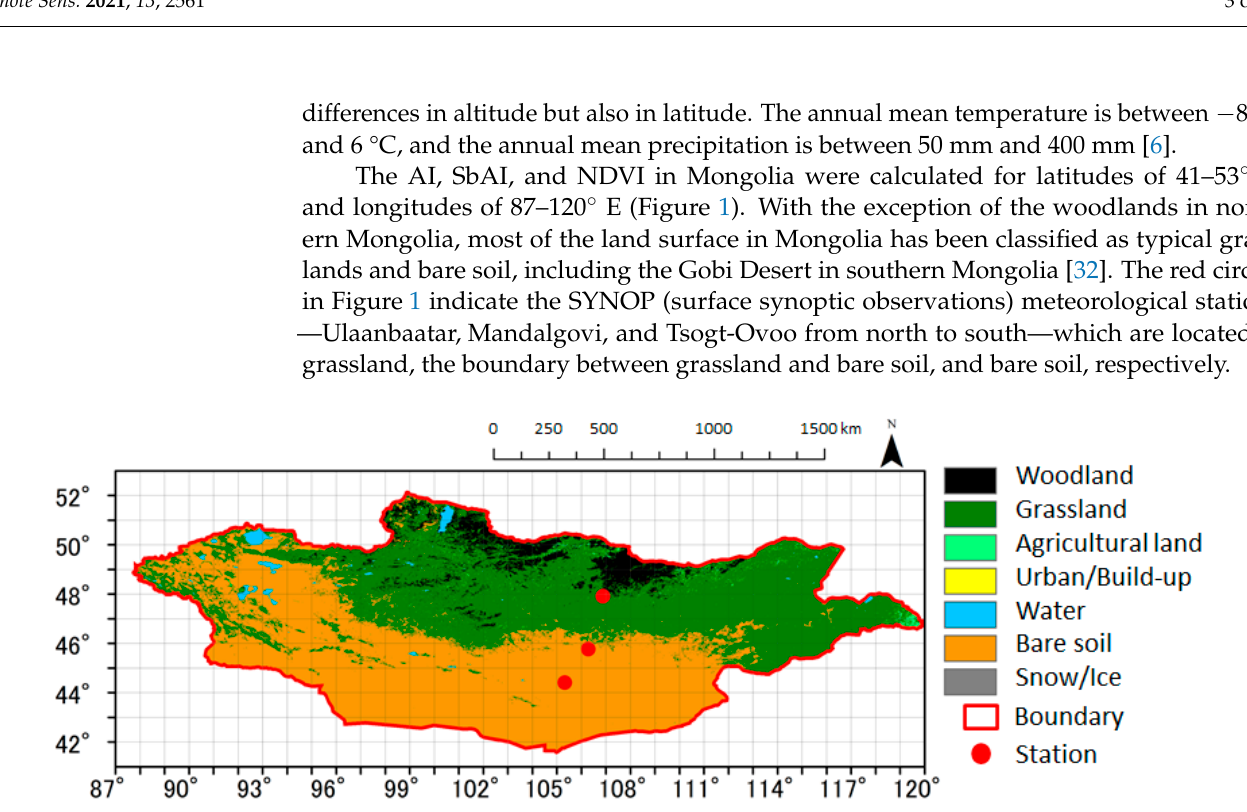
Figure 1. Land-use classification in Mongolia. Dots indicate the SYNOP meteorological stations (Ulaanbaatar, Mandalgovi, and Tsogt-Ovoo from north to south).